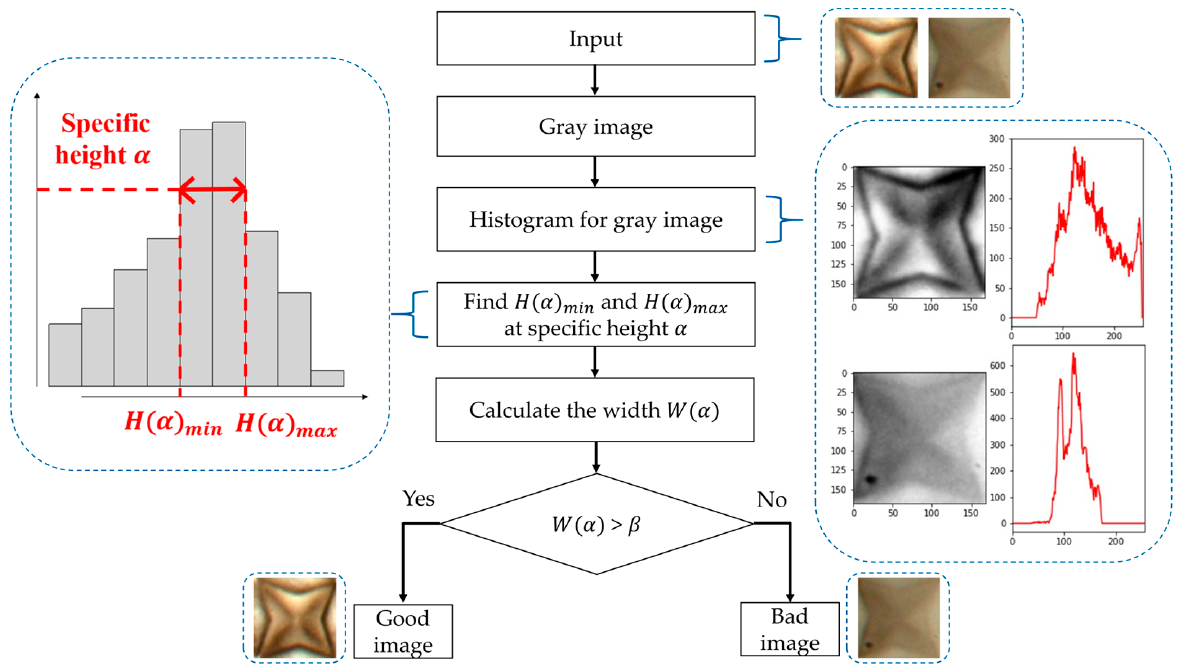
Figure 5. Procedures of the proposed algorithm.